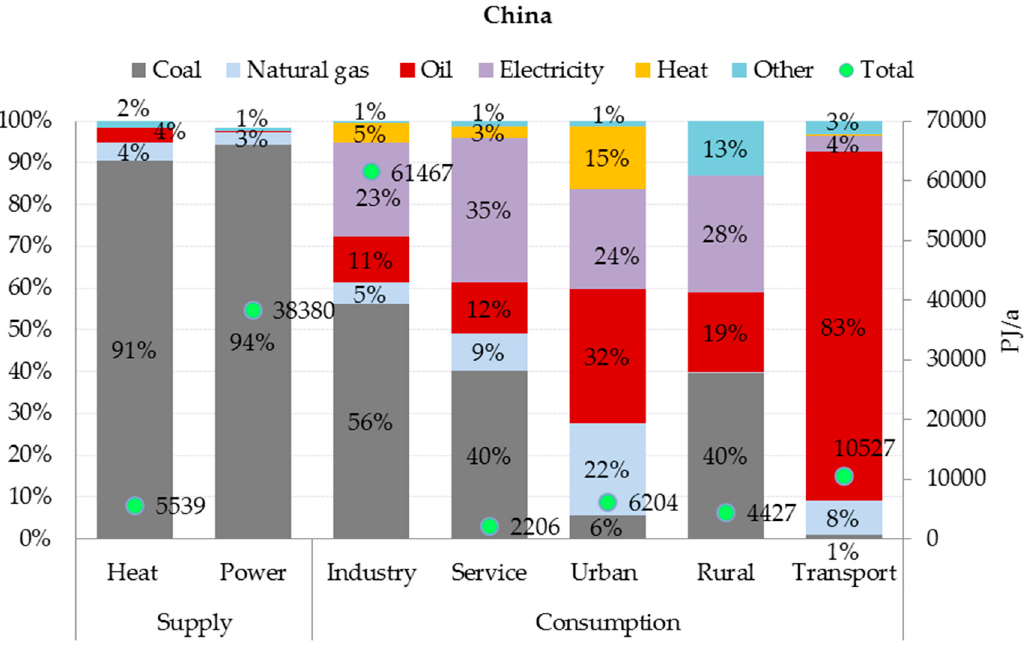
Figure A3. Heat and power energy supply and final energy consumption in China in 2015 by sector [17].